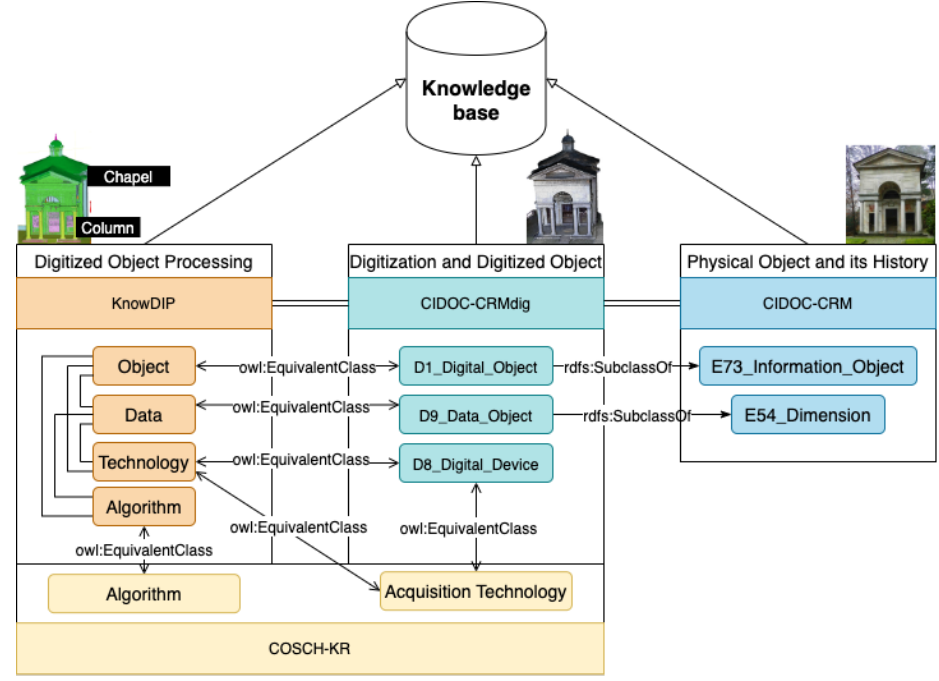
Figure 2. Knowledge base